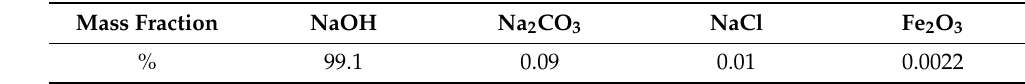
Table 3. Technical index of NaOH.